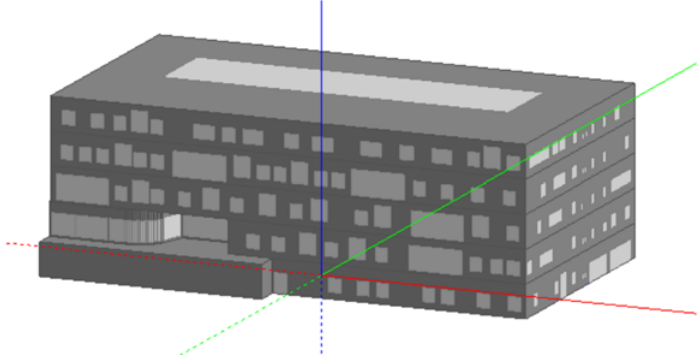
Figure 4. The office building model built by DesignBuilder.